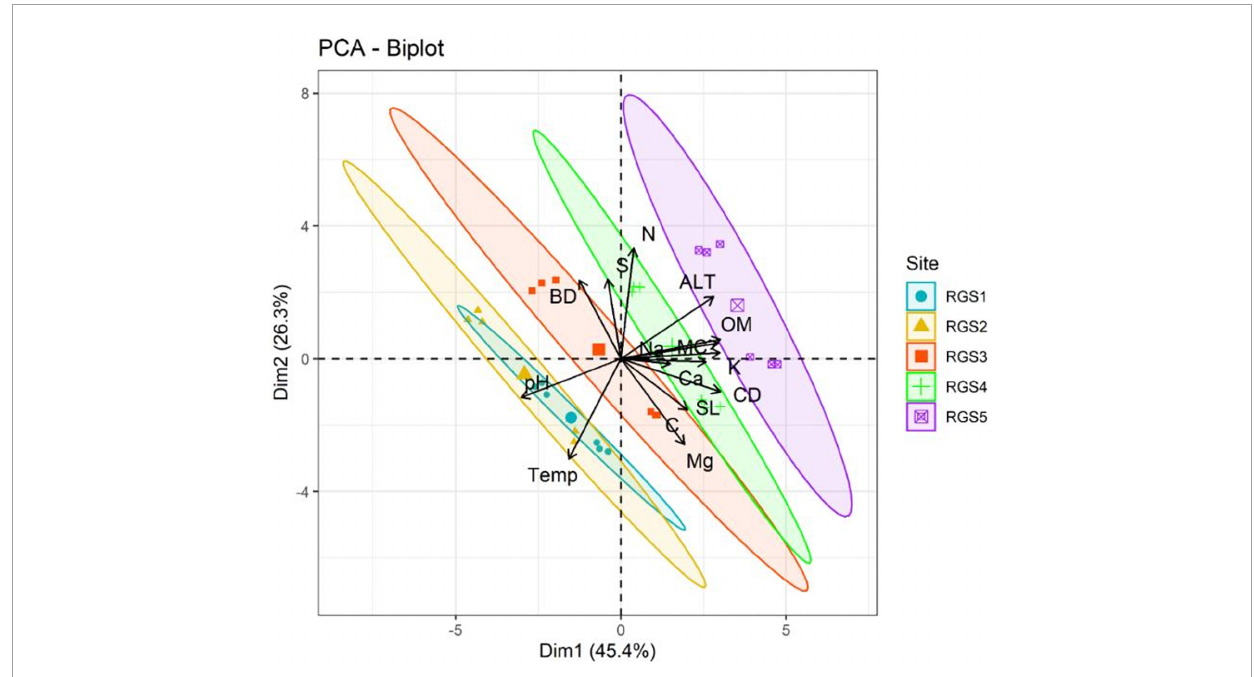
FIGURE3 Principal component analysis (PCA) biplot of Rhododendron anthopogon soil physico-chemical parameters across the five sampling sites: Site-1 (RGS1), Site-2 (RGS2), Site-3 (RGS3), Site-4 (RGS4), and Site-5 (RGS5) along an altitudinal gradient in the Gulmarg area of Kashmir Himalaya. N, total soil nitrogen content; pH, soil pH; Temp, soil temperature; MC, moisture content; BD, bulk density; OM, organic matter; CD, soil electrical conductivity; SL, salinity; C, total soil organic carbon; Mg, magnesium; K, potassium; Ca, calcium; Na, sodium; S, sulfur; ALT, altitude.